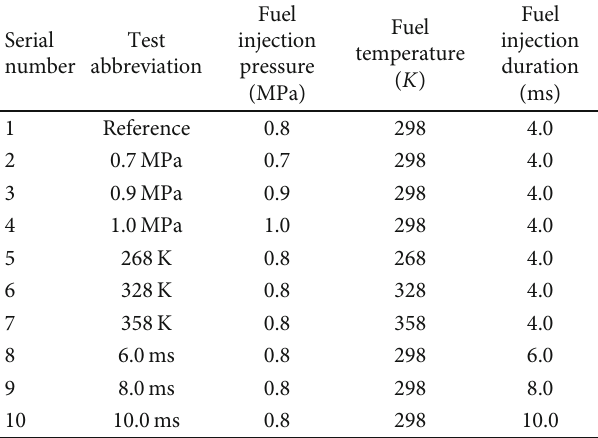
Table 3: Test condition